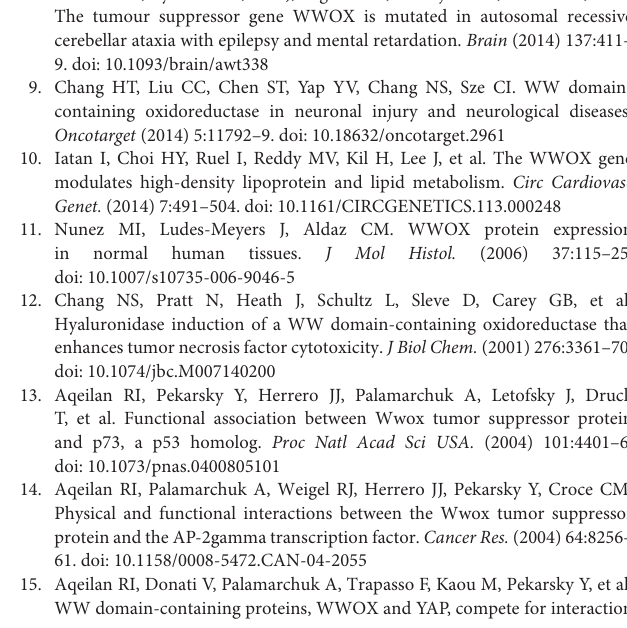
Supplementary File 2 | List of 216 WWOX protein interactors shortlisted based on MUSE and CRAPome analyses. Supplementary File 3 | List of WWOX protein interactors containing PPX(Y/F) and LPX(Y/F) motifs and motif mapping within each protein